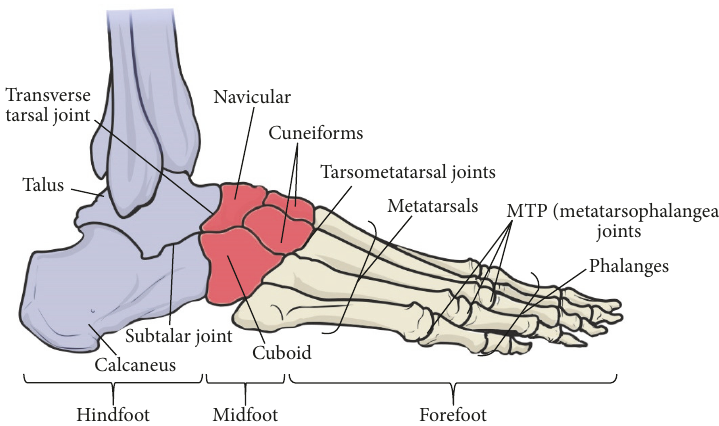
Figure 3: The human foot anatomy [45, 46].